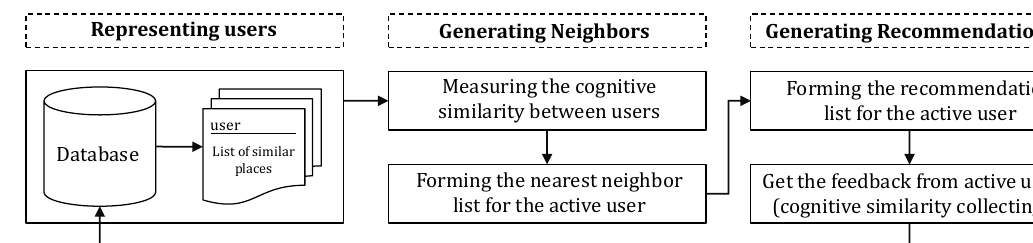
Figure 3. Recommendation